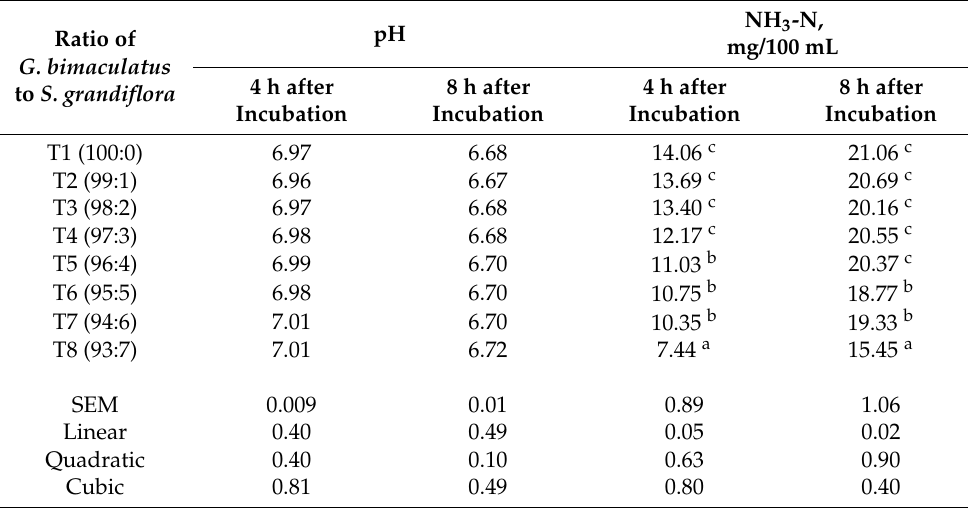
Table 5. Effect of manipulation of in vitro protein degradation from G. bimaculatus powder combine with phytonutrients from S. grandiflora on pH and ammonia nitrogen. Ratio of G. bimaculatus